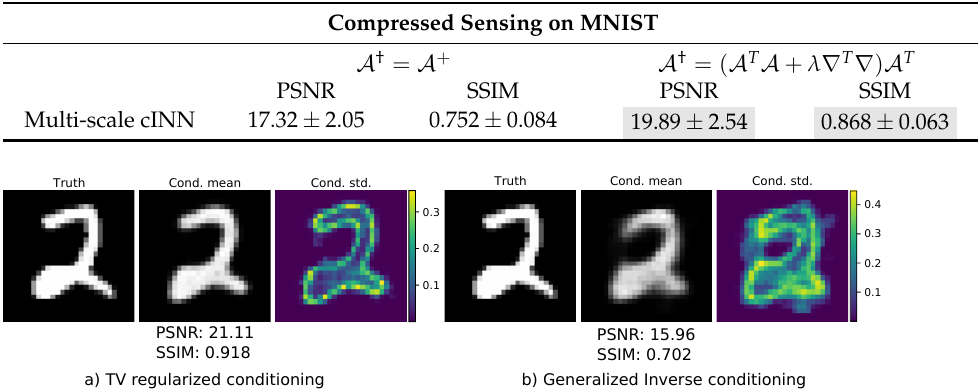
Figure 6. Conditioned mean and standard deviation for the different inversion